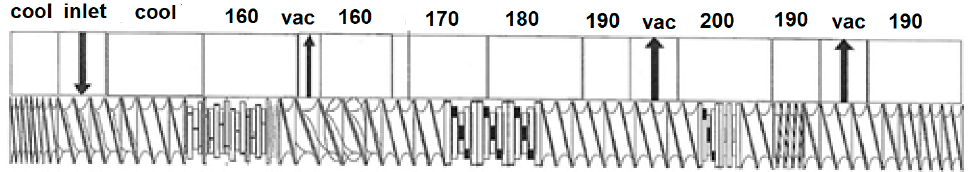
Figure 1 . Screw profile . Figure 1. Screw profile.